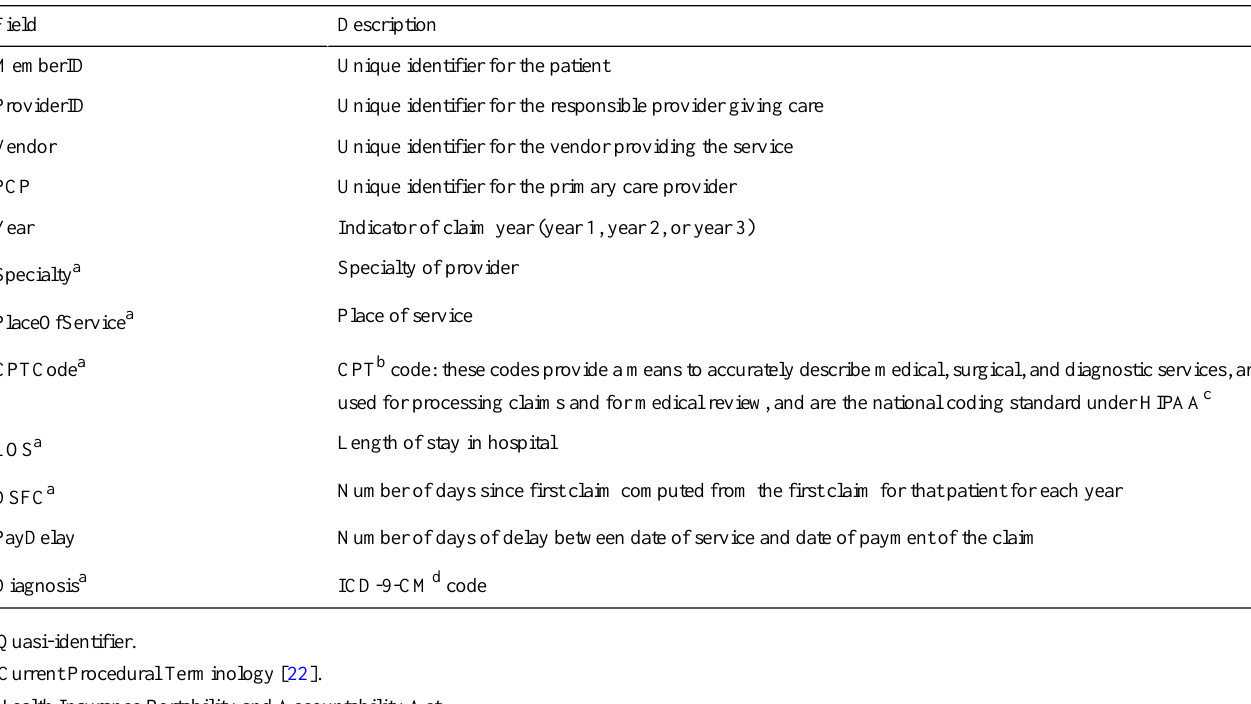
Table 3. Description of the fields for the claims data table.